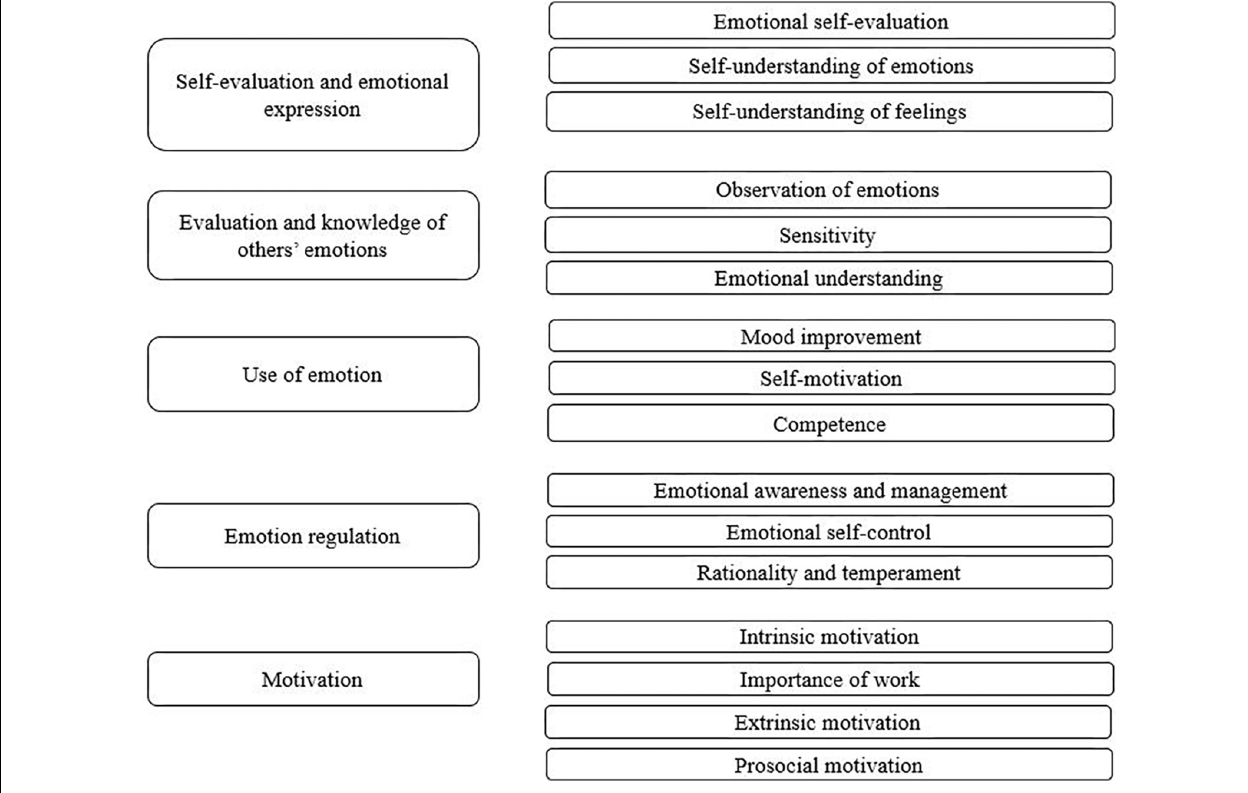
FIGURE 1 | Emotions and motivation within the sports